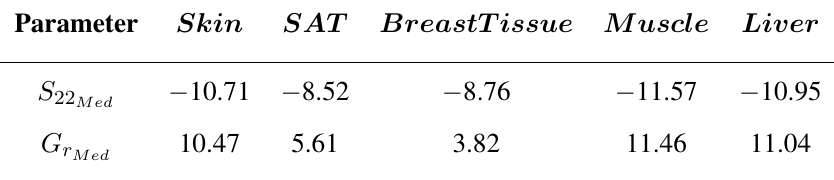
( dB ) and G 22 Med